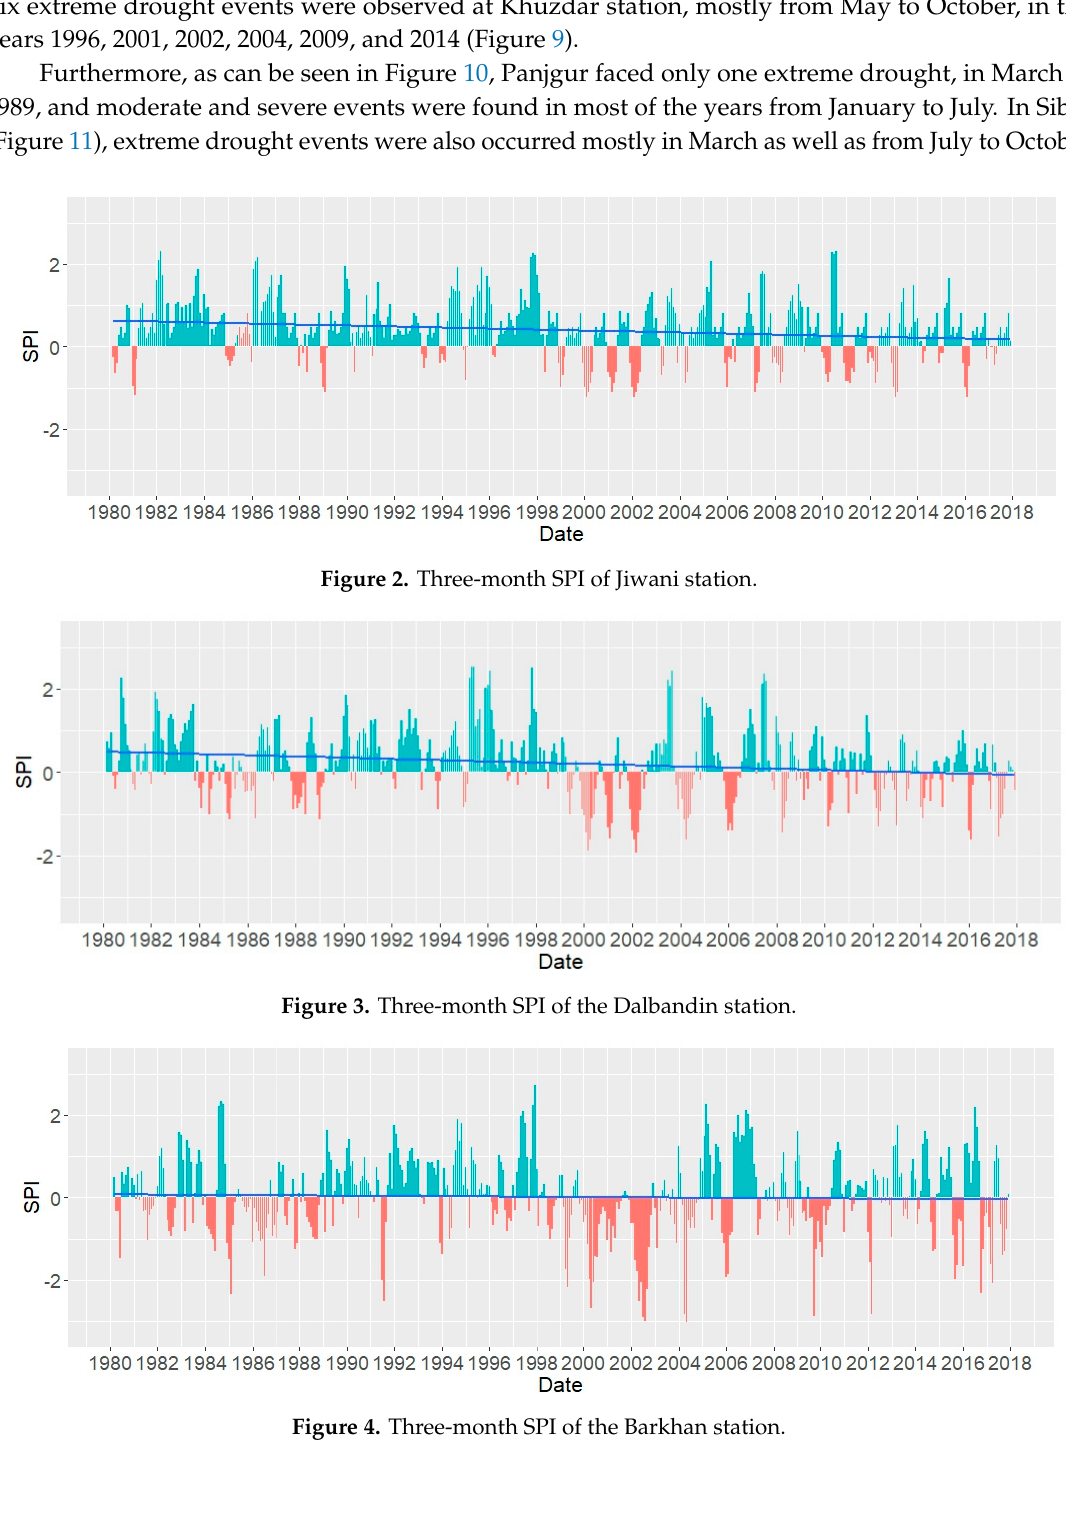
Figure 5. Three-month SPI of the Quetta station. Figure 6. Three-month SPI of the Nok kundi station. Figure 7. Three-month SPI of the Pasni station.